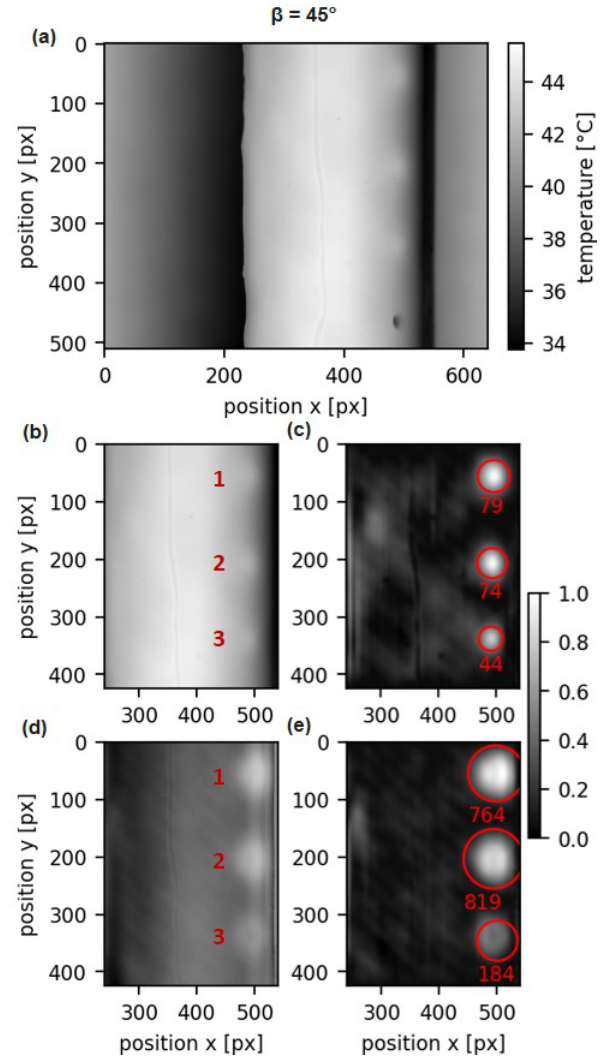
Figure 10. Results of test series 3 ( β = 45 ◦ , ROI A, t exc = 25s, t rec = 15s, k = 89mm, ( a ) surface temperature of the whole camera FOV, ( b ) result for the reference method without filtering at t rec = 0s, ( c ) reference image with filtering, automatic defect detection and calculation of the CNR, ( d ) result for the PCA-based method without filtering, ( e ) PCA-based image with filtering, automatic defect detection and calculation of the